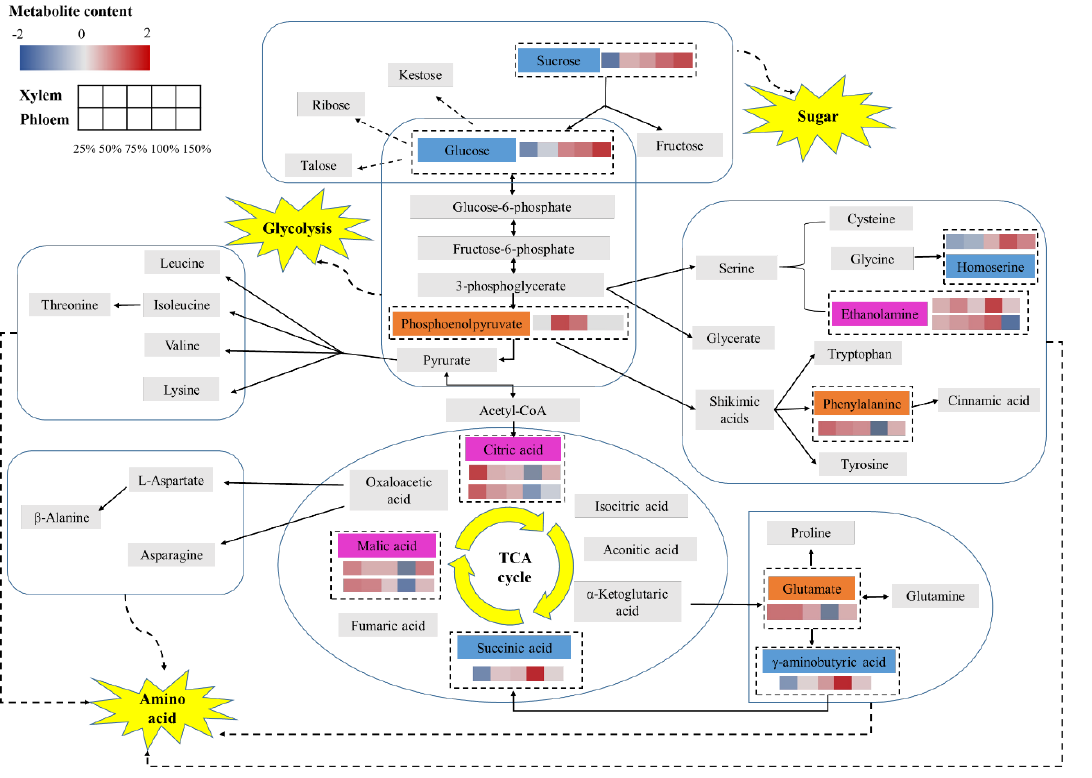
Figure 5. Metabolic network changes for xylem and phloem sap of cucumber upon phosphorus stress. The orange rectangle represents extremely significant differential metabolites on key pathways in xylem; the blue rectangle represents extremely significant differential metabolites on the key pathways in phloem; the purple rectangle represents extremely significant differential metabolites in key pathways shared by xylem and phloem; the first row (xylem) and the second row (phloem) had small hot boxes, showing the changes of key differentially expressed metabolites under phosphorus stress (P25%, P50%, P75%, P100%, P150%).